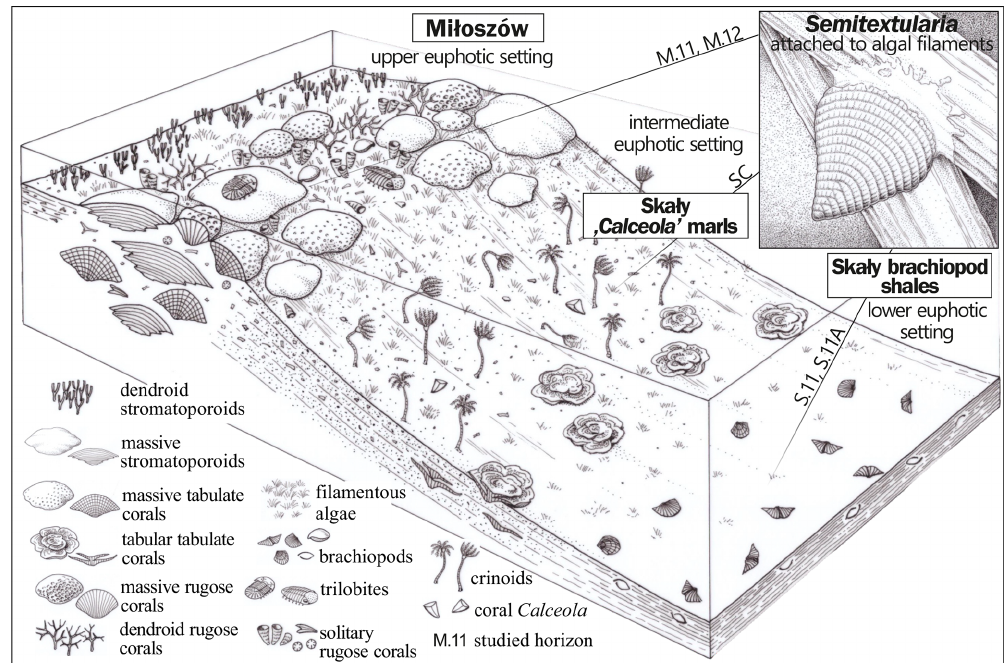
Figure 5. Simplified depositional biofacies model for the uppermost Eifelian Skały Formation in the Łysogóry basin (HCM), with general locations indicated for Semitextularia -bearing